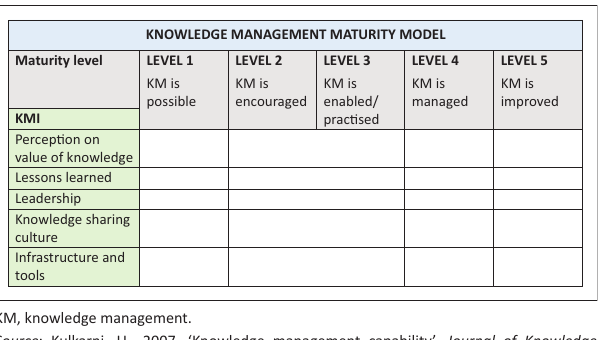
FIGURE 1: Knowledge management maturity